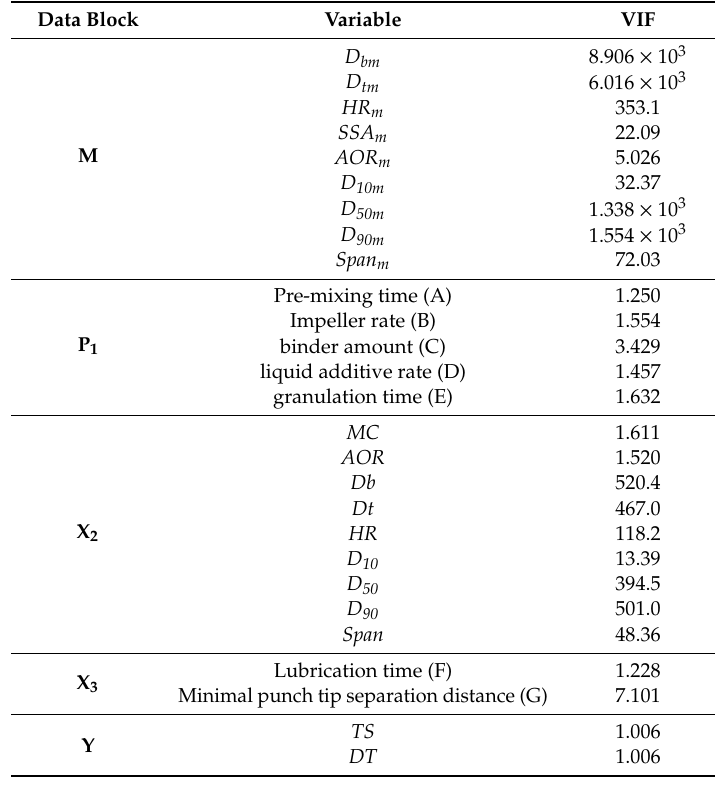
Table 4. Variance inflation factor (VIF) calculated for variables in each data